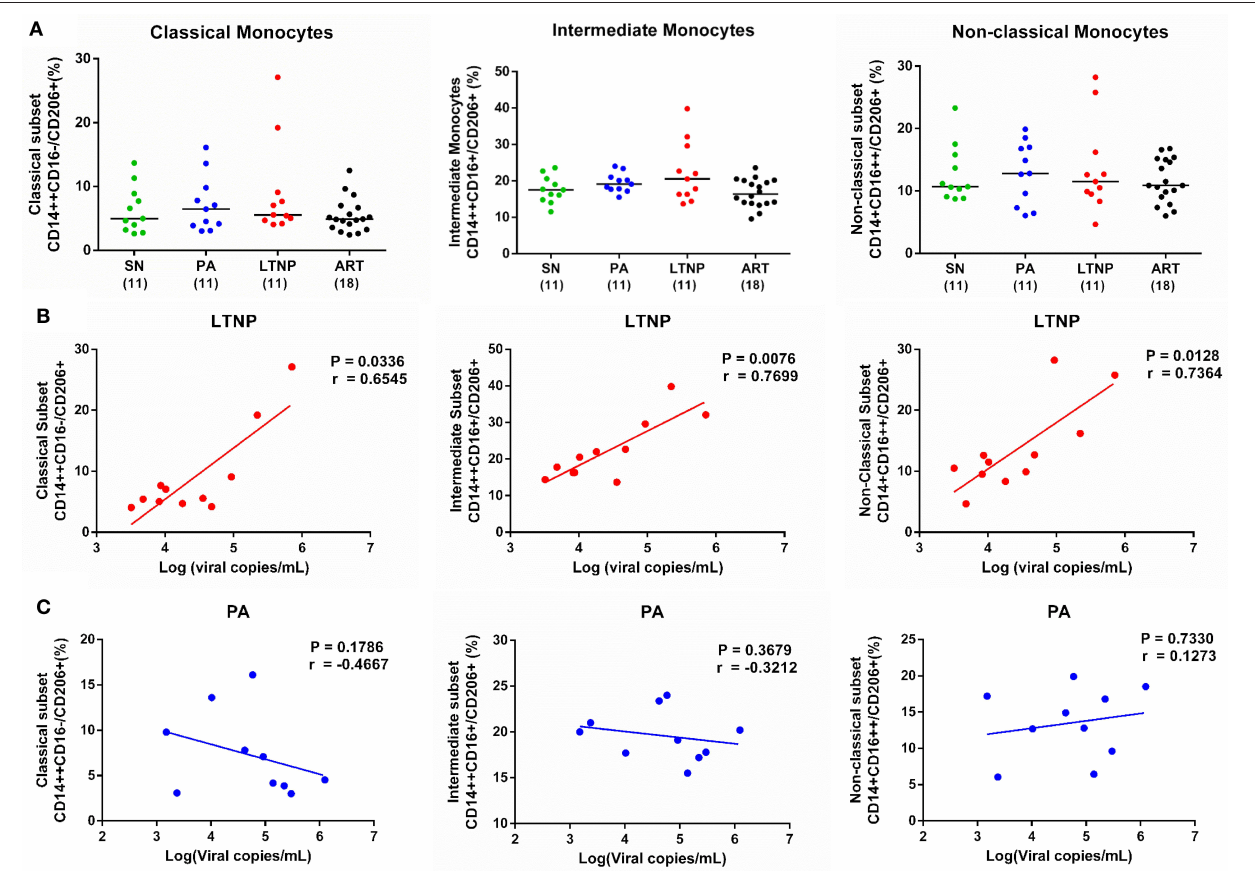
FIGURE 6 | Expression of CD206 across cohorts and its association with viremia in therapy-naïve groups. (A) Expression of CD206 in monocyte subsets across PA ( n = 11), LTNP ( n = 11), ART ( n = 18), and SN ( n = 11) groups. Kruskal-Wallis ANOVA followed by Dunn’s multiple comparison test was carried out to measure significance. The apparent increase in CD206 expression on intermediate monocytes was observed to be significantly higher in PA ( P < 0.05) and LTNP ( P = 0.05) groups compared to therapy receiving individuals using unpaired t -test. (B,C) Correlation analyses of CD206 on monocyte subsets with viremia in LTNP and PA groups, respectively. Association between variables is assessed using Spearman correlation analysis to determine correlation co-efficient “ r ” and test significance ( P < 0.05).